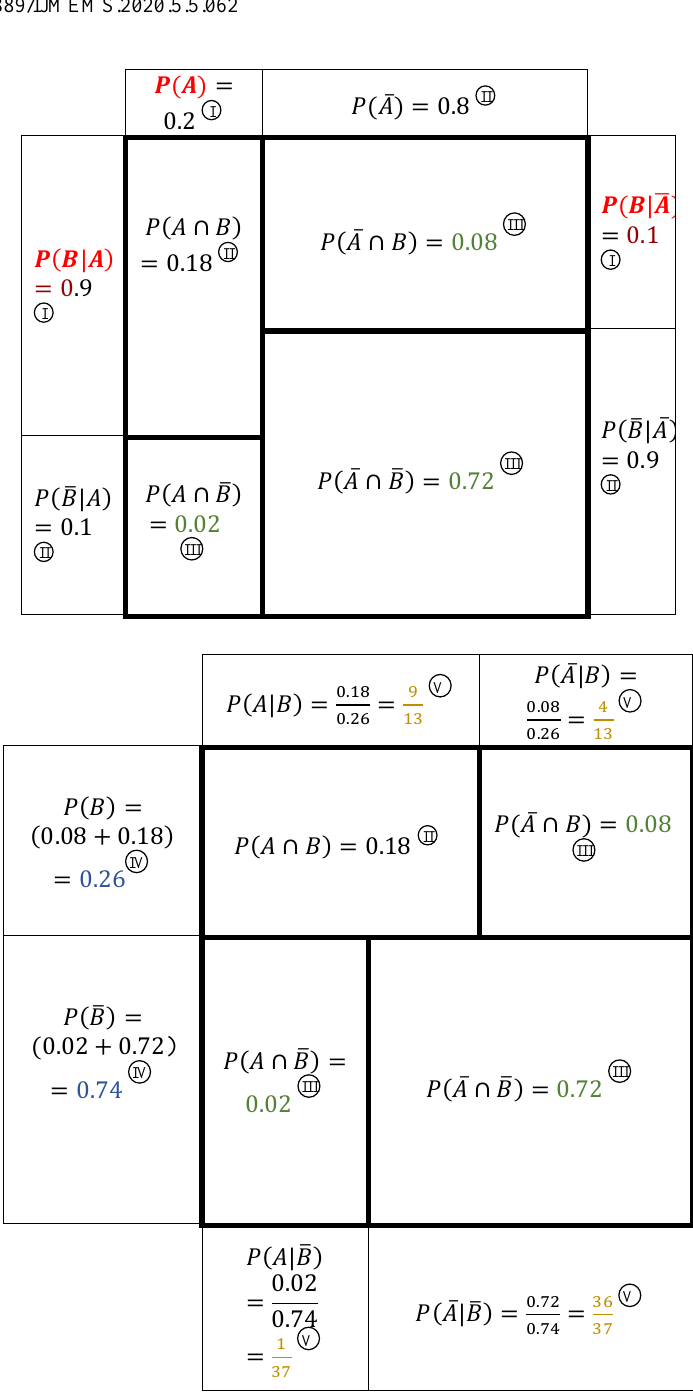
Figure 8. Arithmetic solution of a ternary problem of conditional probability given the three known values 𝑃(𝐴) = 0.2 , 𝑃(𝐵|𝐴) = 0.9 , and 𝑃(𝐵|𝐴 ̅ ) =